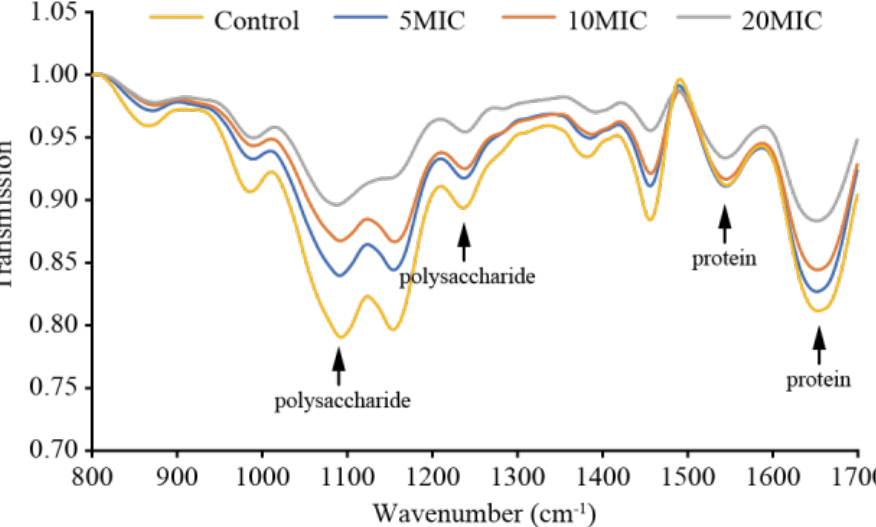
Figure 10. ATR-FTIR spectra of C. sakazakii biofilms on stainless steel.